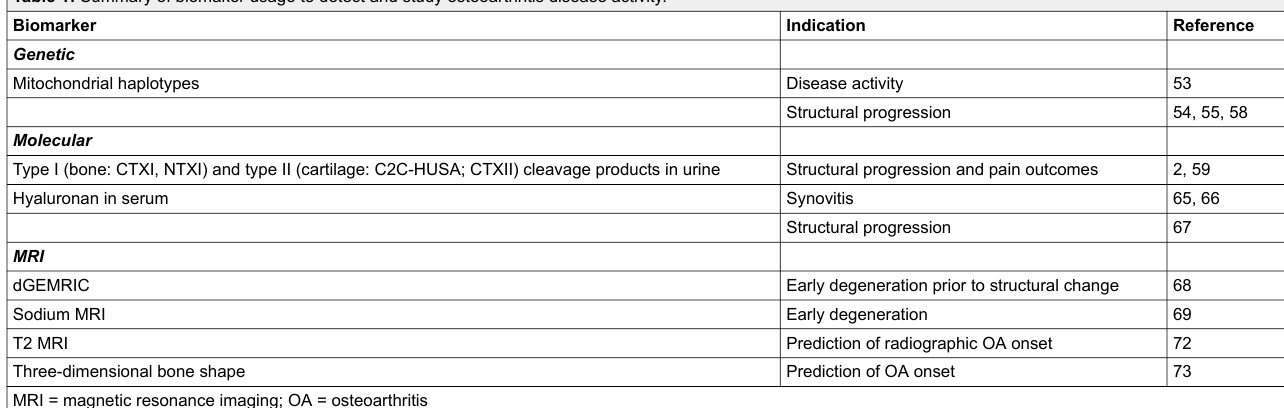
Table 1: Summary of biomaker usage to detect and study osteoarthritis disease